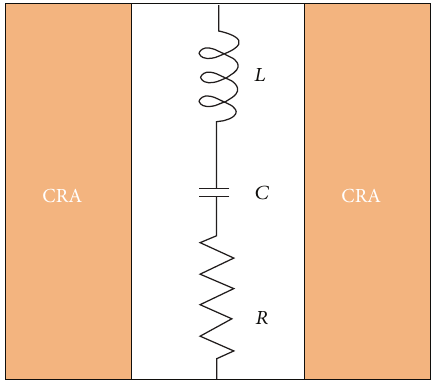
Figure 2: Equivalent circuit model of the capacitive RF MEMS switches [7].